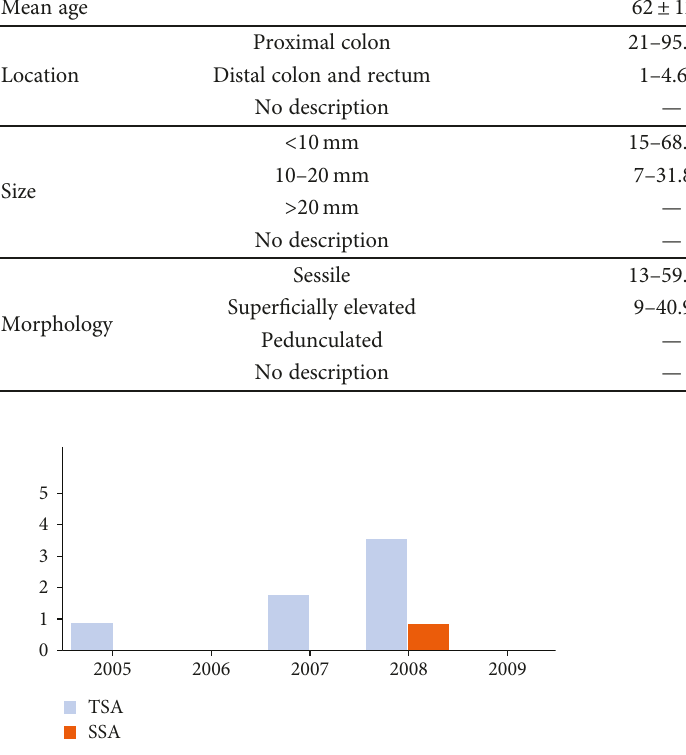
Figure 2: Number of sessile serrated adenomas and traditional serrated adenomas from 2010 to 2014 (year; lesions diagnosed — absolute value). Two sessile serrated adenomas were diagnosed in 2010, six in 2011, fi ve in 2012, three in 2013, and fi ve in 2014. The number of traditional adenomas diagnosed was fi ve in 2010, three in 2011, one in 2012, two in 2013, and three in (0.1% to 14.7%), relative to all polyps found in the colon.